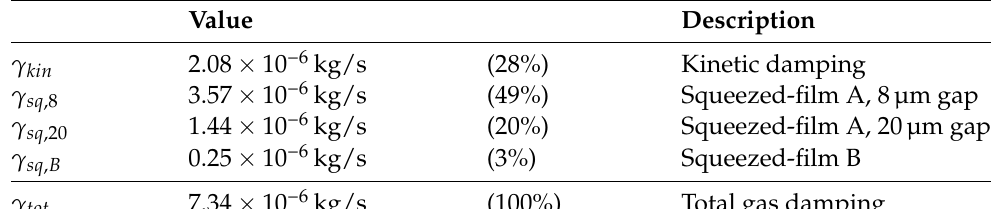
Table 2. Damping contributions in air (300K, 0.1mbar).